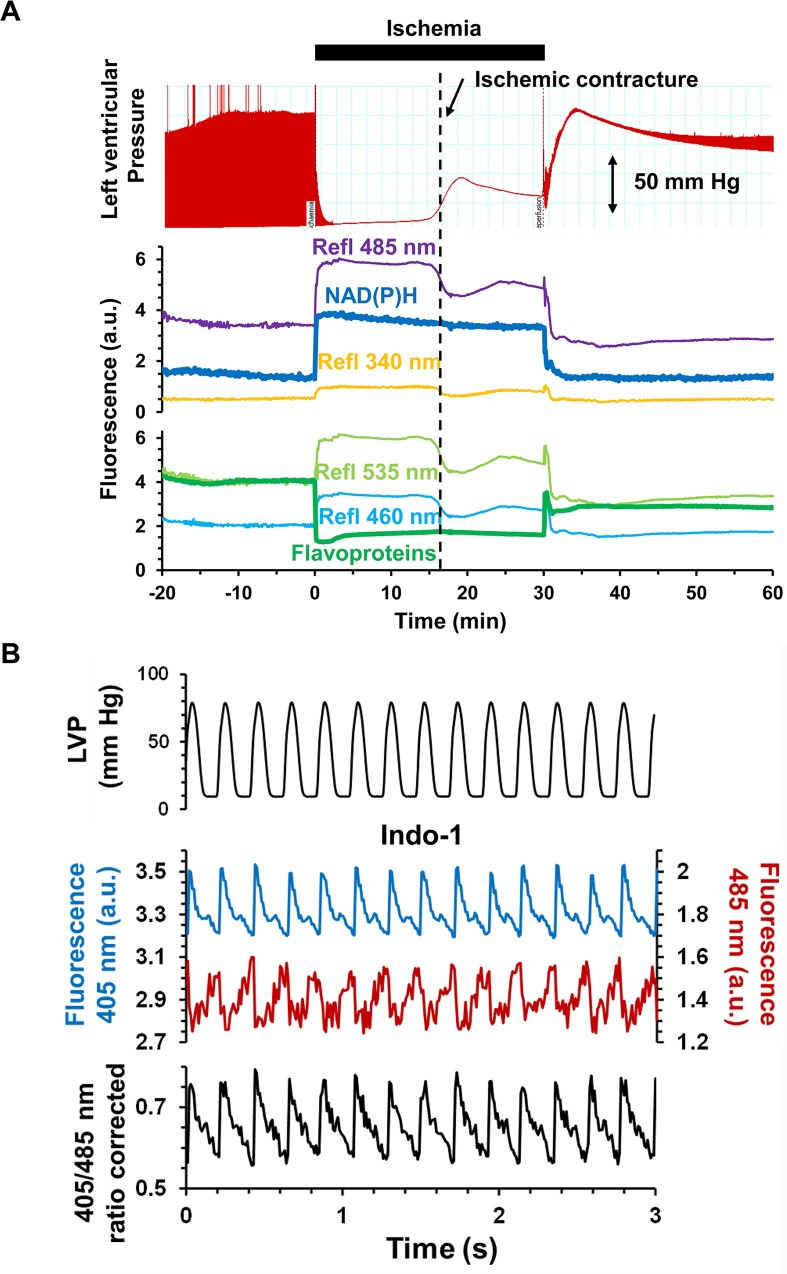
Validation of the bespoke surface fluorescence apparatus.A, Time course of NAD(P)H (top) and flavoprotein (bottom) surface fluorescence and the reflectance signals at the corresponding excitation and emission wavelengths together with data for the left ventricular pressure (LVP). B, Example of Indo-1 fluorescence transients recorded at 405 nm (in blue) and at 485 nm (in red), and Indo-1 ratio calculated after subtracting background autofluorescence. The top trace shows corresponding LVP data.